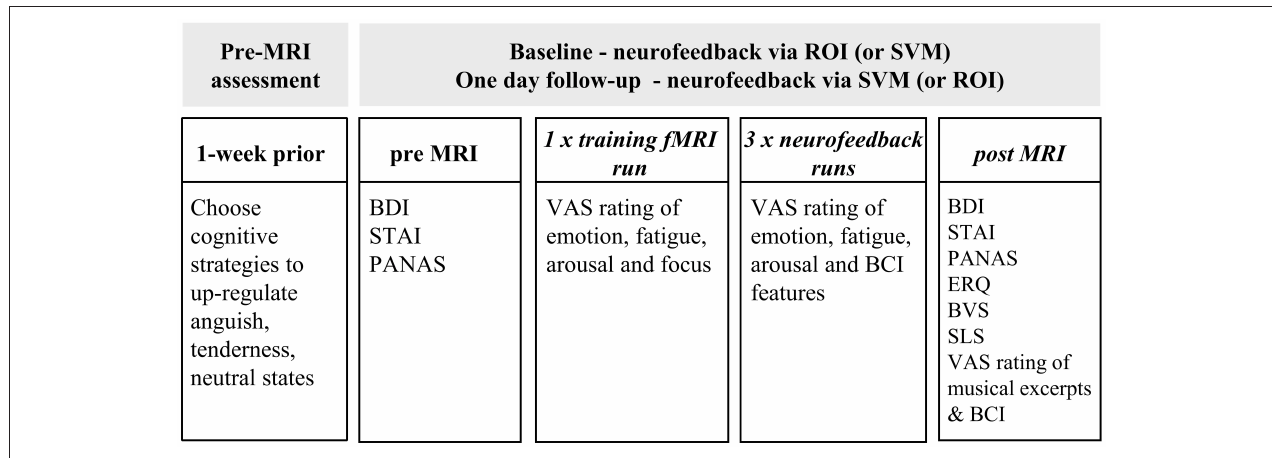
FIGURE 3 | Outline of the assessment protocol. Assessments were identical across sites and days (baseline and day 2), with questionnaires administration before, during and after the MRI assessment and training/NFB runs. Unknowingly, each participant was delivered NFB using a distinct NFB method (either SVM = support vector machine or ROI = region of interest) on each of the two assessment days (gray box). Half of the participants delivered a ROI NFB method at baseline and a SVM NFB method at the one-day follow up. The other half underwent SVM NFB first and ROI NFB at follow up. BDI = Beck Depression Inventory ( 36), ROI = region of interest; STAI = Spielberger State and Trait Anxiety Inventory (37); PANAS = Positive and Negative Affect Scale (38). ERQ = Emotion Regulation Questionnaire (39), BVS = Body Vigilance Scale ( 40), SLS = Satisfaction with Life Scale (41).